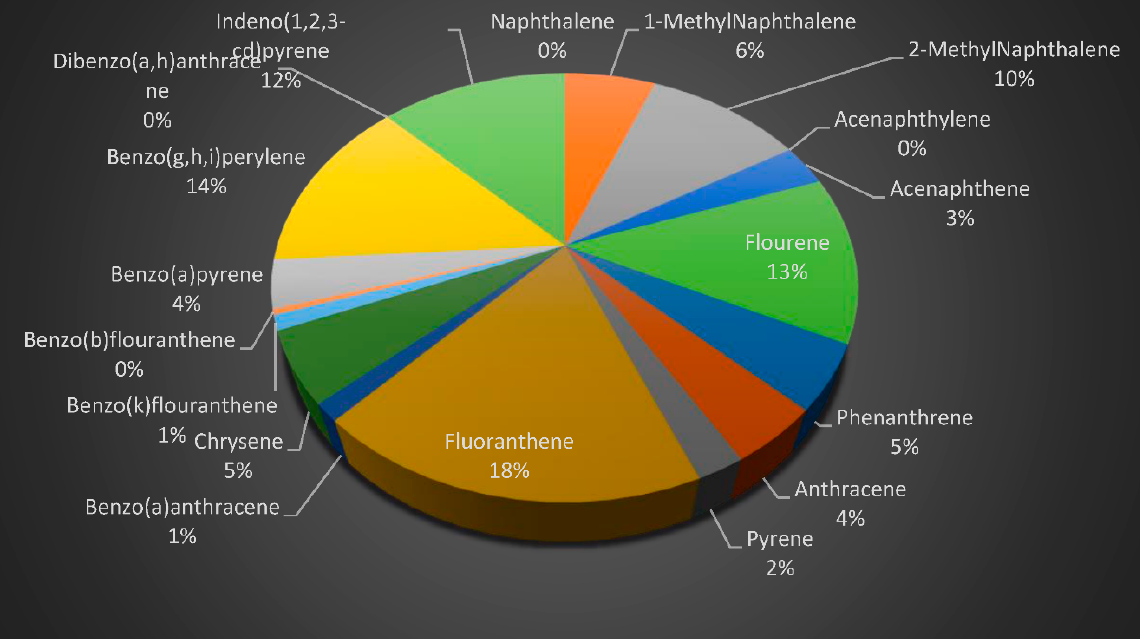
Figure 8. Percentage contributions of PAHs in the soil samples.